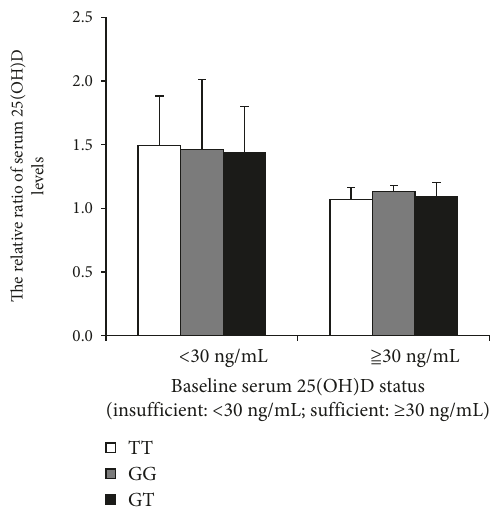
Figure 3: Comparison of serum 25(OH)D in the patients with di ff erent CYP27B1 rs10877012 genotypes before and after vitamin D supplementation. The vertical axis is the relative ratio of serum 3 25(OH)D before and after 30 months of vitamin D3 supplementation. Insu ffi ciency: serum 25(OH)D level of < 30 ng/mL; su ffi ciency: serum 25(OH)D level of ≥ 30 ng/mL. There was no signi fi cant di ff erence in the increase of serum 25(OH)D levels in patients of TT, GG, and GT genotype after supplementation. All P values were >